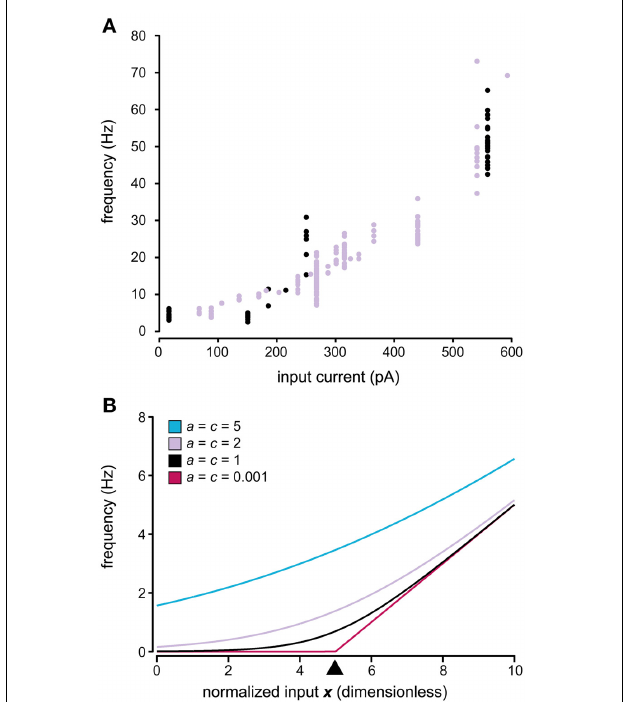
FIGURE 3 | Relationship between input and output in the model of spike generation. (A) Relationship between injected current and the firing frequency for two spinal interneurons. Note the tendency of a smooth non-linearity rather than a sharp threshold as the frequency approaches 0Hz. (B) Relationship between the input and the firing frequency using different parameters in the model of spike generation described in Equation (3). The values of parameters a and c are shown in the figure, where the value of c determines the width of the non-linear region. a = c in the figure to facilitate comparison between the curves as the slope of the linear asymptote, as the normalized input increases, equals a / c . The value of parameter b is set to 5, which means that the threshold is centered over 5, indicated by the black arrowhead. b has the same value in all curves shown. Note that both a sharp threshold is attained by having c close to 0, whereas a smoother transition is obtained with higher values of c